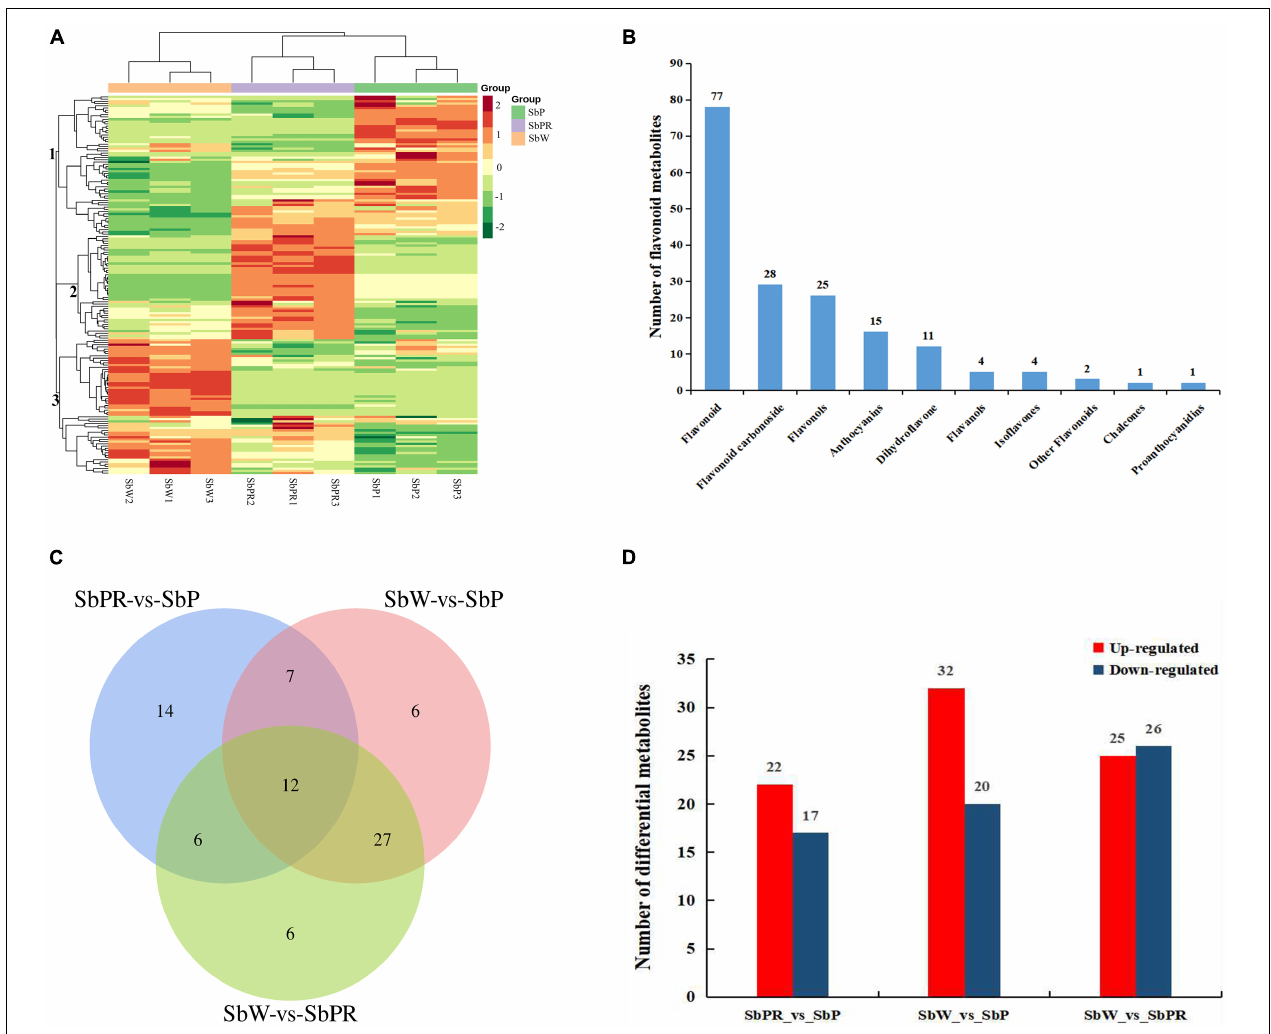
FIGURE 2 | Flavonoid metabolome profiles of the petals of white, purple-red, and purple flowers in Scutellaria baicalensis . (A) Heatmap clustering showing the correlation among white, purple-red, and purple flower samples based on 168 metabolite profiles. The color scale from red to green indicates the normalized metabolite levels using the row Z-score. (B) Classification of the 168 identified metabolites into 10 groups. (C) Venn diagram indicating the shared and specific number of the differential metabolites identified by each package. (D) Numbers of differential metabolites. SbW: white flower at the blooming stage; SbPR, purple-red flower at the blooming stage; SbP, purple flower at the blooming